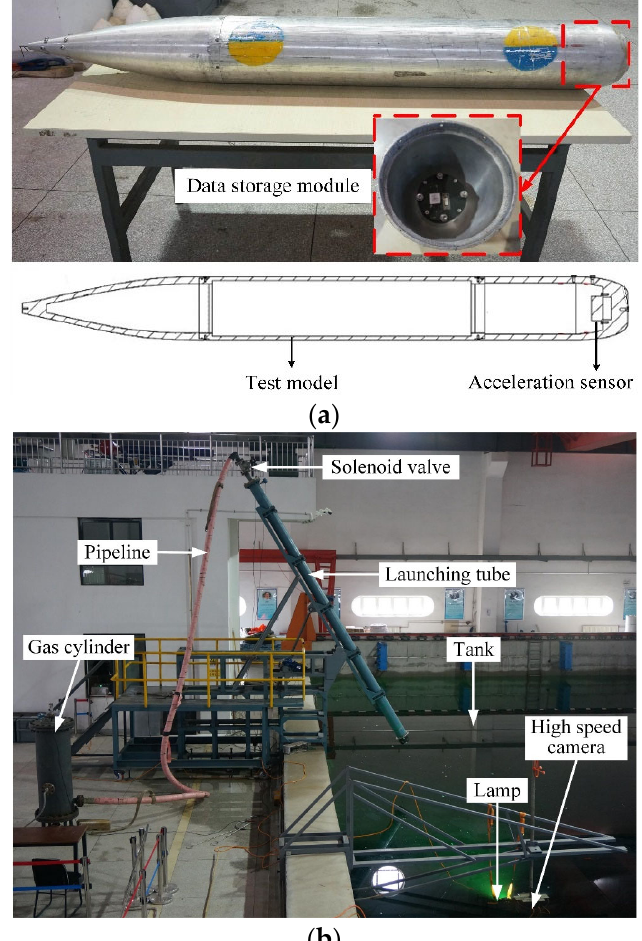
Figure 4. Test model and experiment device. ( a ) Test model. ( b ) Experiment device.